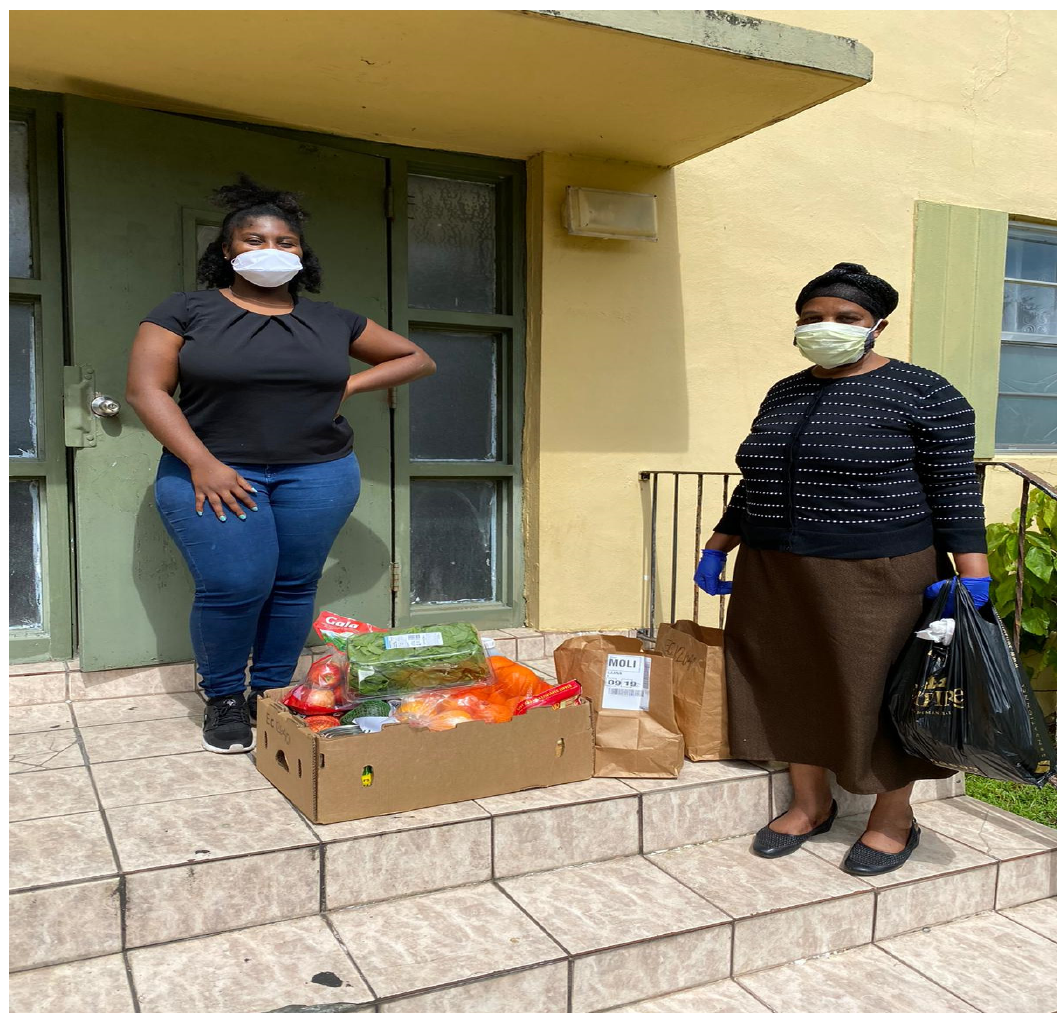
Figure 4. Food Delivery to a NeighborhoodHELP Household.